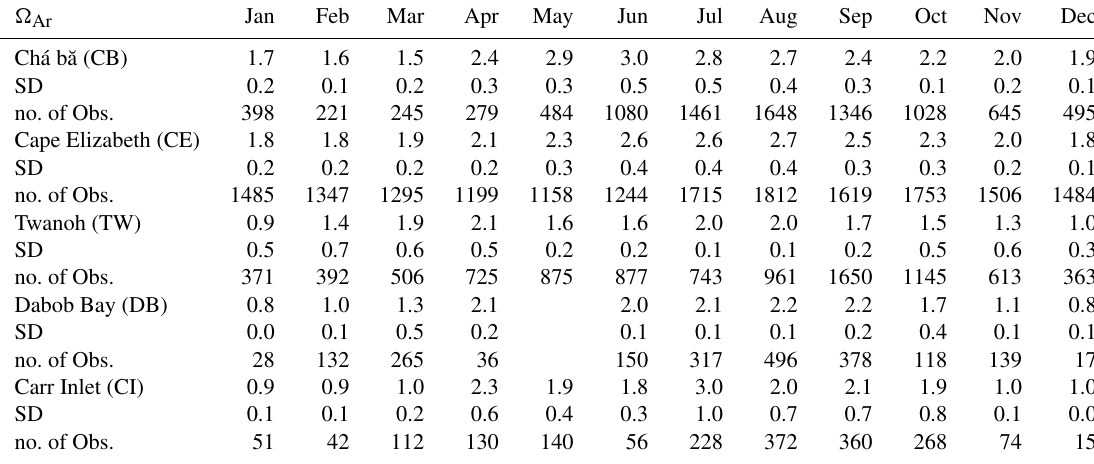
Table C7. Average monthly (cid:127) Ar seasonal cycles for the five Washington State moorings with sufficient observations to estimate (cid:127) Ar . The average monthly standard deviation (SD) and total number of observations (no. of Obs.) contributing to the monthly average estimate are